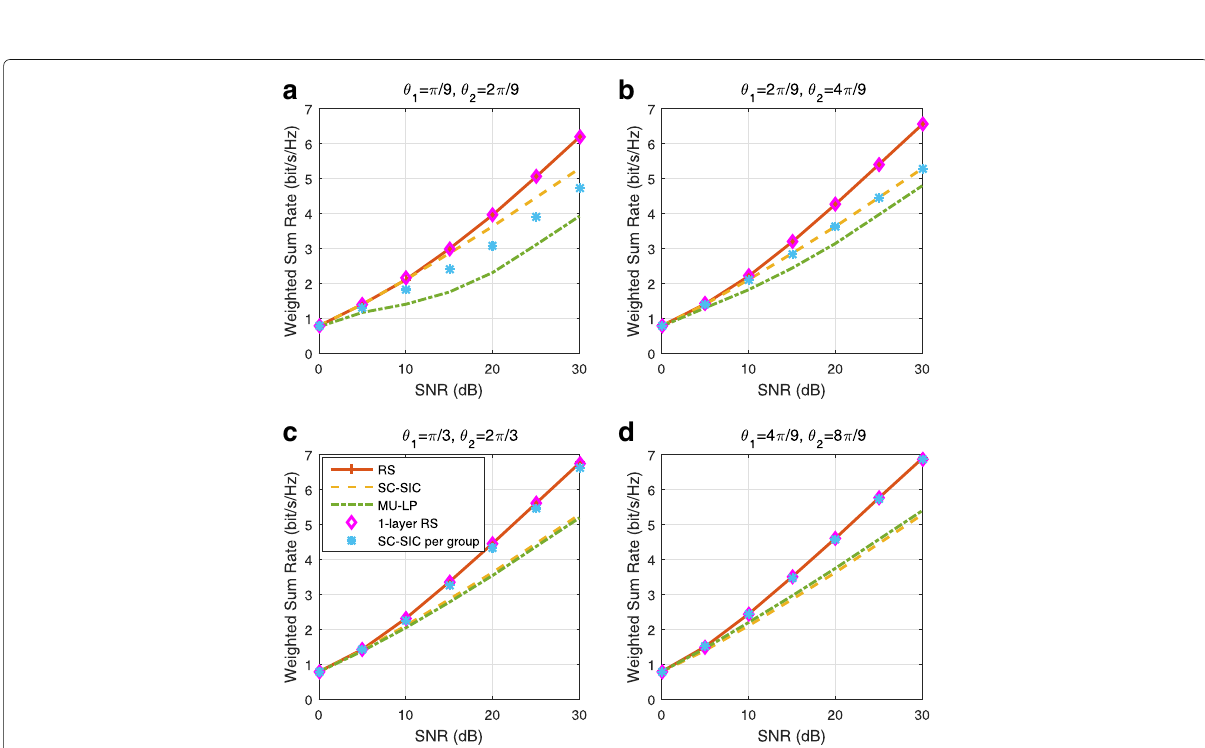
Fig.39 WeightedsumrateversusSNRcomparisonofdifferentstrategiesforoverloadedthree-userdeploymentwithperfectCSIT, γ 1 = γ 2 = 1, u 1 =